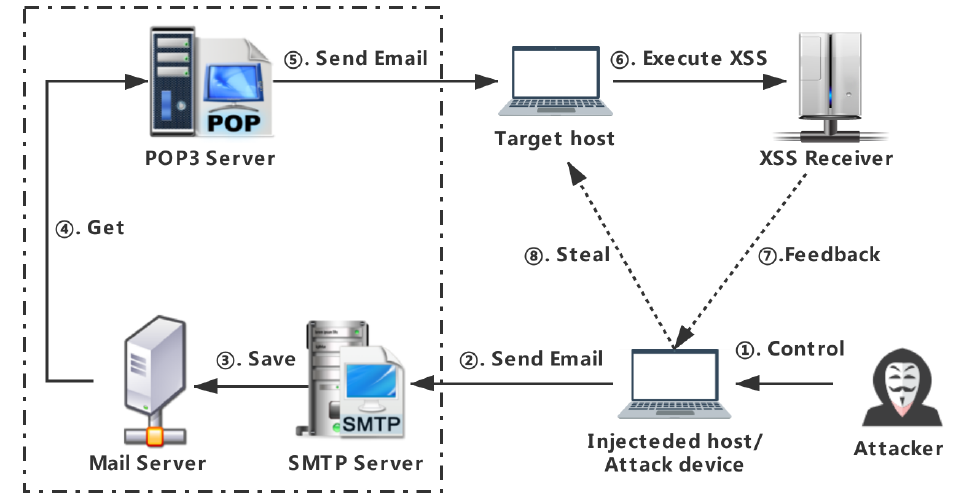
Figure 1. Email Cross-Site Scripting (XSS) attack